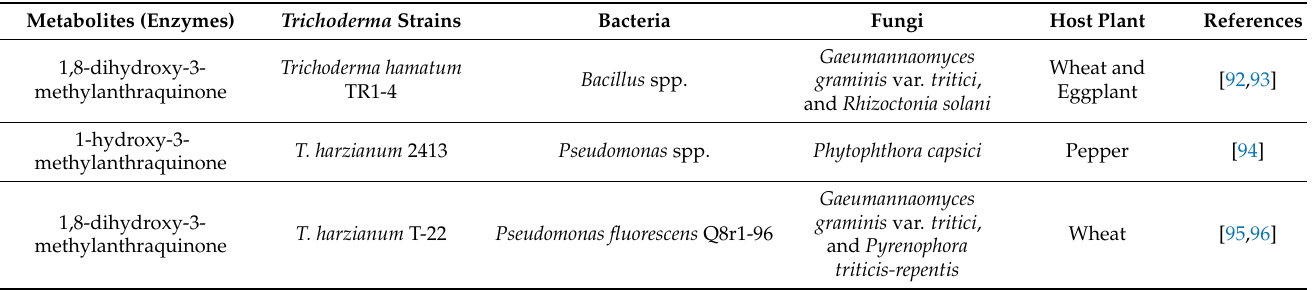
Table 3. Rhizosphere metabolites secreted by crop roots, Trichoderma, and soil microbial